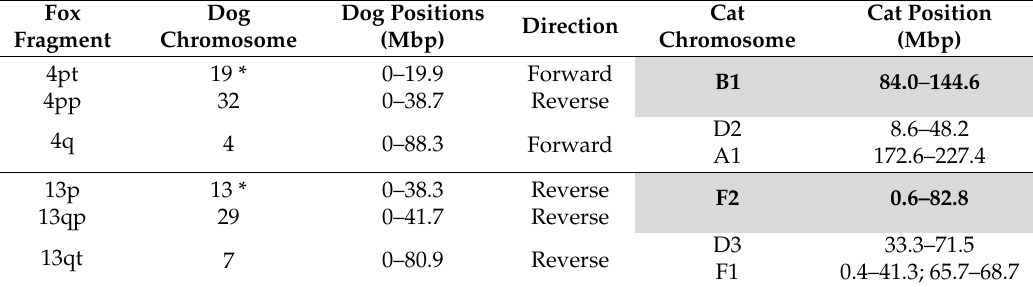
Figure 3. The fox chromosomal segments shown alongside the corresponding syntenic chromosomes in dog and cat. Fox chromosomal fragments are ordered to approximate the full assembled chromosome, and chromosome numbers appear inside of or alongside fragments. Asterisks indicate dog chromosomes that map in more than one syntenic block to fox. Dog and fox fragments are to scale; cat fragments are approximately to scale. Syntenic blocks smaller than 500 Kbp (found only for the cat) are not shown. Table 2. Conserved synteny between cat and fox relative to dog. Alignment of the dog genome assembly (CanFam3.1) and cat genome assembly (FelCat5). Top: against VVU4; bottom: against VVU13. In these three cases, fox and cat map in a single syntenic block whereas fox and dog map in two blocks, as indicated by bold text. The cat syntenic blocks spanning two dog syntenic blocks are shaded. Genomic positions in CanFam3.1 and FelCat5 are indicated. * Indicates chromosome comprised by two dog-fox syntenic